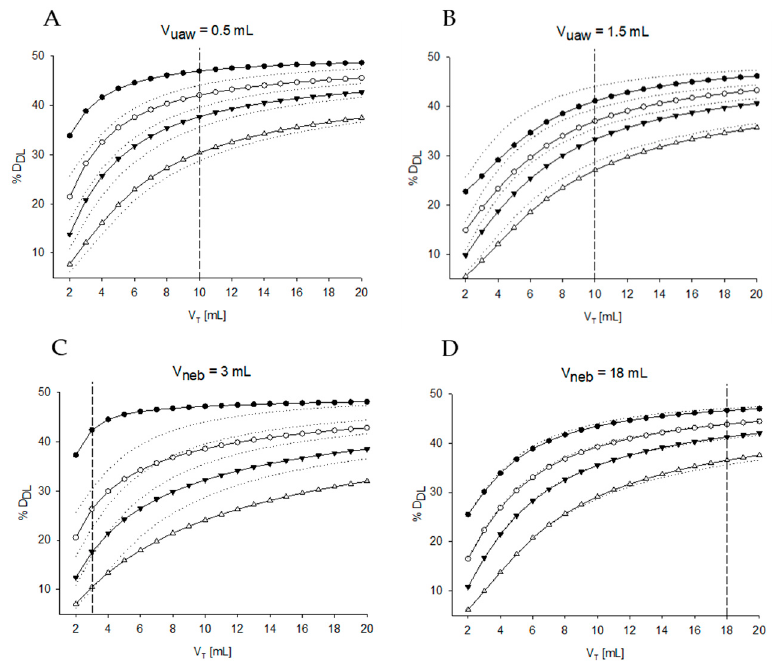
Figure 5. ( A ) Percentage of drug delivered to the lung (%D DL ) over V T in case the volume of the upper airways compartment is 0.5 mL or ( B ) 1.5 mL (Table 1, Simulation 4). ( C ) %D DL over V T in case the volume of the nebulizer is 3 mL or ( D ) 18 mL (Table 1, Simulation 5). Dotted lines represent the baseline condition (Table 1, Simulation 1). The dashed line represents the selected nebulizer volume and emphasizes the response of the system at tidal volume smaller (left) or bigger (right) than the dead space of the nebulizer. V T = tidal volume, D DL = dose delivered to the lung, V neb = internal volume of the nebulizer, V uaw = volume of the conductive airways.